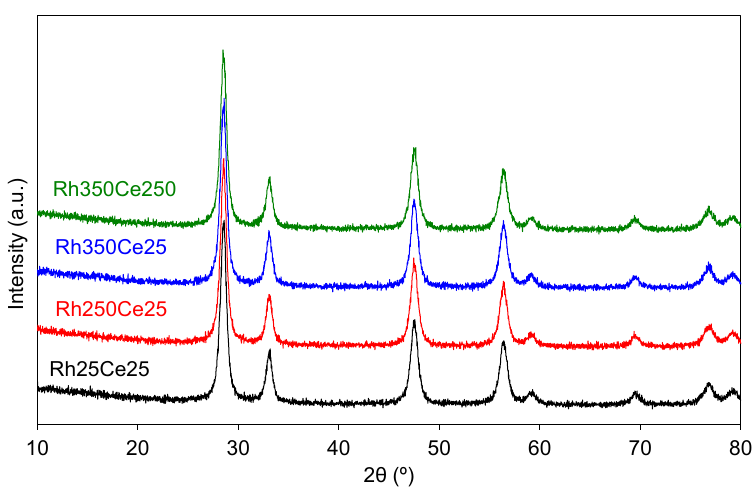
Figure 2. XRD patterns of fresh catalysts.